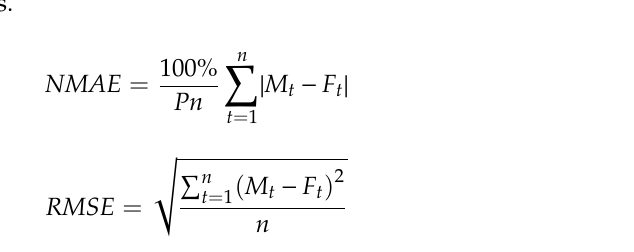
Figure 5. Spatial modeling results (the x axis represents the 1 h intervals of time for the estimated period).